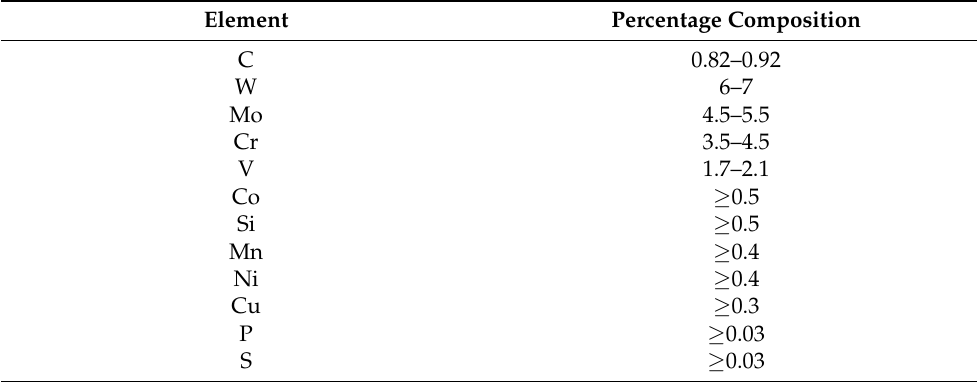
Table 5. Chemical composition of HS6-5-2C high-speed